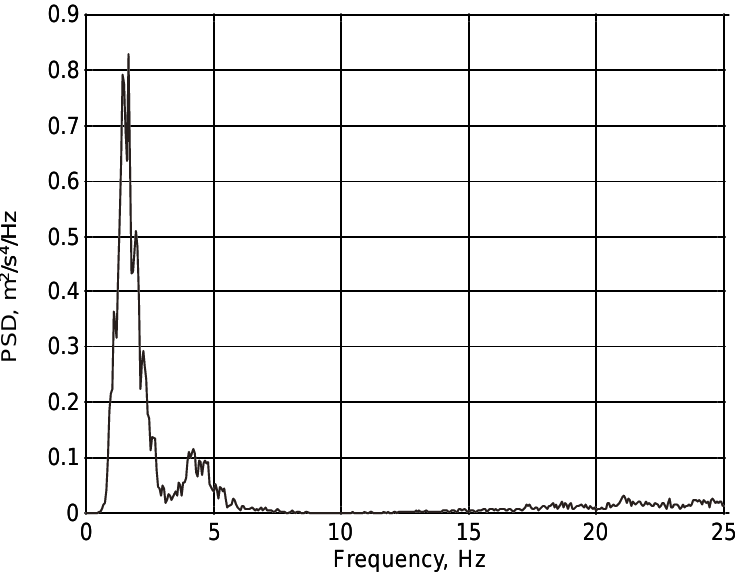
Fig. 5. Sprung mass acceleration (system response) power spectral density due to ISO 2 excitation for a skyhook damper.